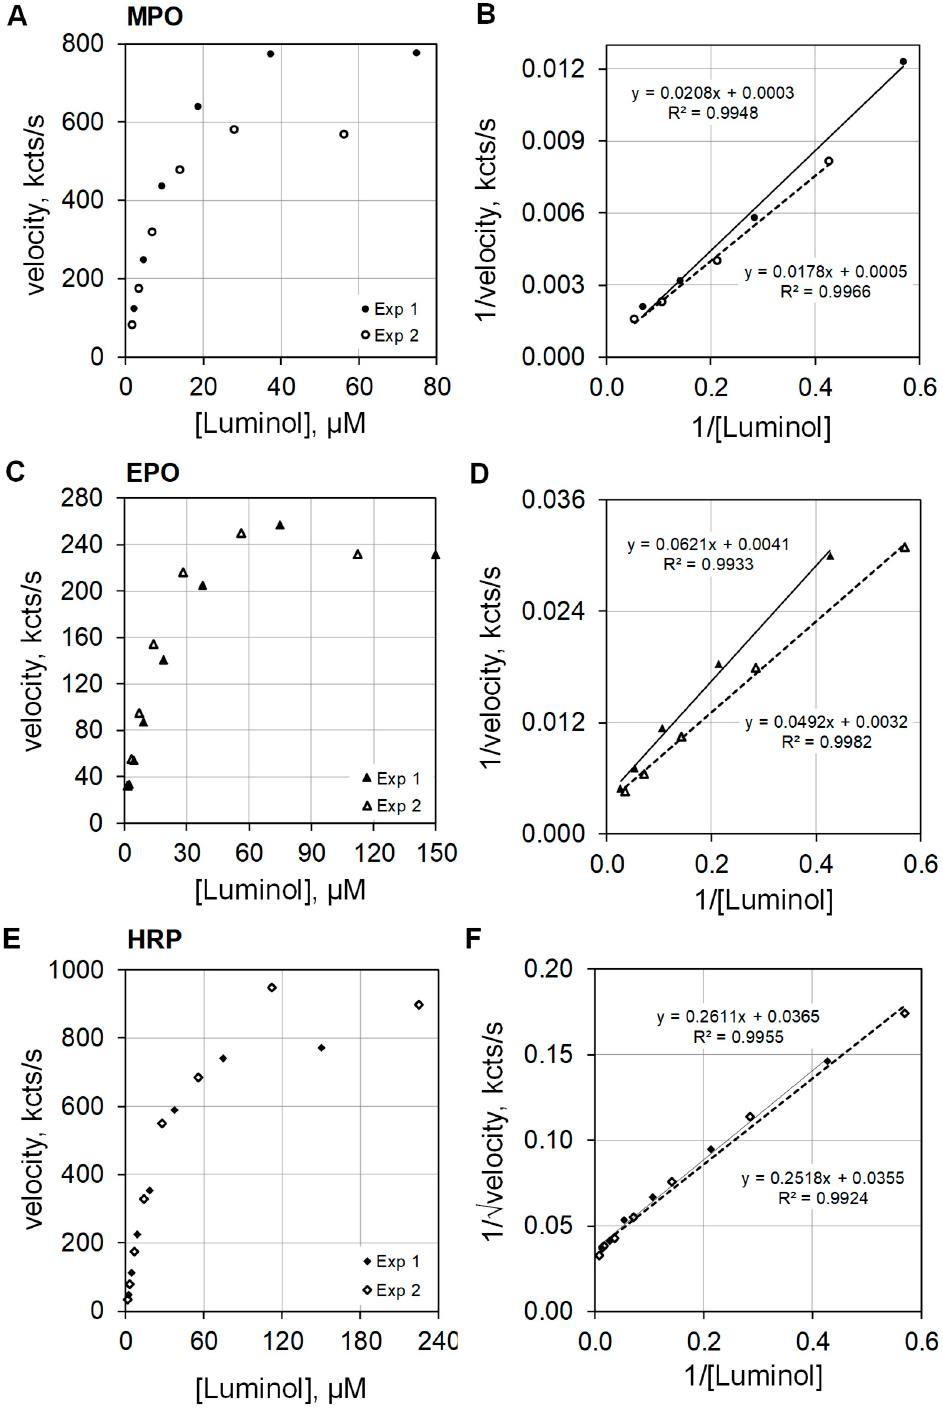
Figure 5. Plots of luminescence velocity against luminol concentration for MPO, EPO, and HRP. The top graphics present the results using 100 nM MPO with 100 mEq/L Cl − ( A ), the middle graphics present the results using 100 nM EPO with 10 mEq/L Br − ( C ), and the bottom graphics present the results using 100 nM HRP without halide ( E ). The plots to the right show double reciprocal plots of 1/velocity (1/(kcts/s)) against 1/[luminol] (1/( µ M)) for MPO ( B ) and EPO ( D ). For HRP, the double √ √ reciprocal plots show 1/ velocity (1/ (kcts/s)) against 1/[luminol] (1/( µ M)) ( F ). MPO and EPO activities were measured in 50 mM acetate buffer at pH 5. HRP activity was measured in 50 mM phosphate buffer at pH 7. Reaction was initiated by mixing reactants with 2.5 mM H 2 O 2 . The final volume was 1.0